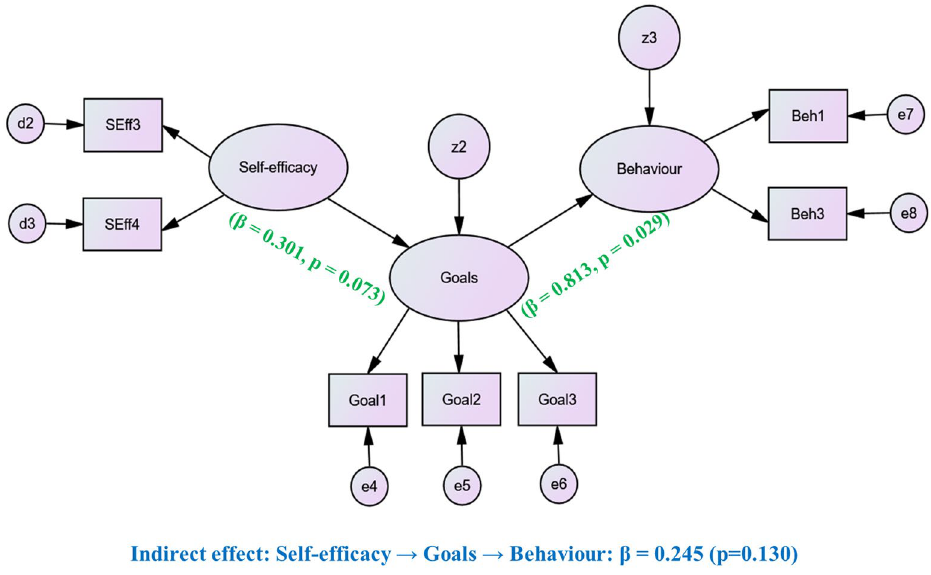
Figure 1. Final Structural Equation Model describing farmers’ behaviour towards antimicrobial administration on commercial chicken farms in Chattogram, Bangladesh that is based on the ‘Social Cognitive Theory’ framework 25 . ‘Observed variables’ are presented in rectangles and the ‘latent constructs’ are presented in ovals. Both ‘d’ and ‘e’ represent errors of measurements, while ‘z’ represents the residuals of the latent